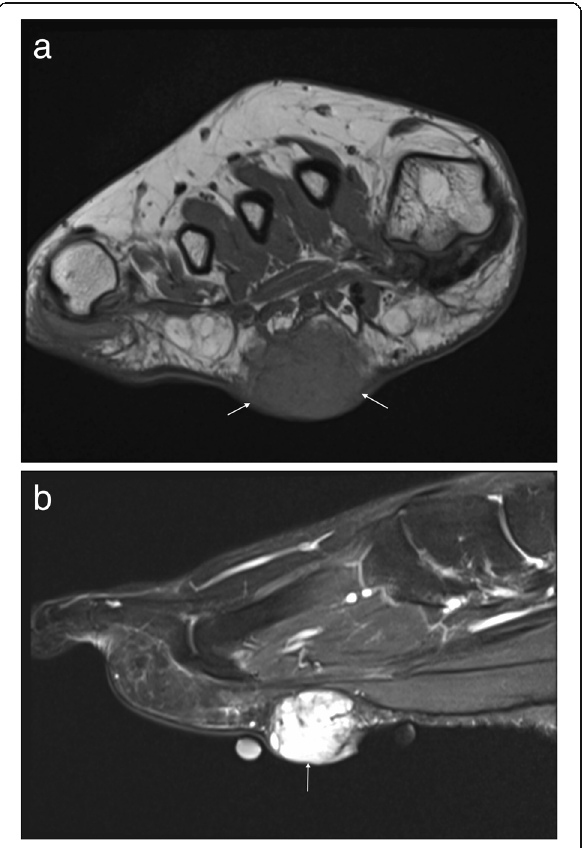
Fig. 14 Extraosseous Ewing ’ s sarcoma. a Coronal T1W and ( b ) sagittal T2FS images of the foot. The lesion is isointense on T1W and hyperintense on T2FS and lies superficial to the plantar